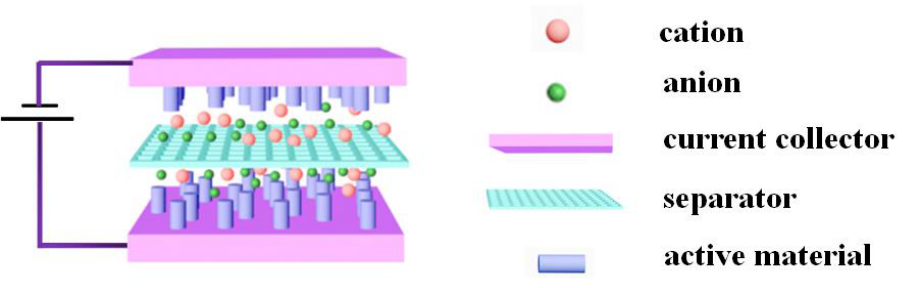
Figure 5. The schematic mechanism of the supercapacitors device.